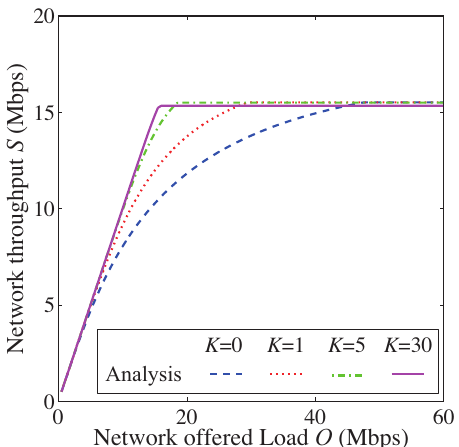
Figure 14. Network throughput as a function of offered load for N = 5 and K = 0,1,5, and